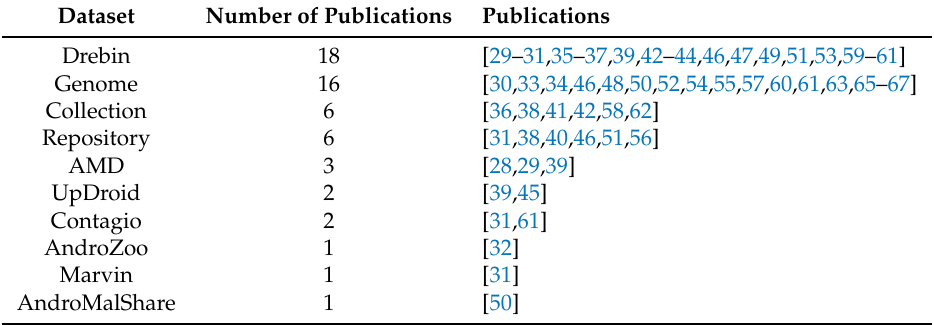
Table 3. Dataset, number of publications and publication details